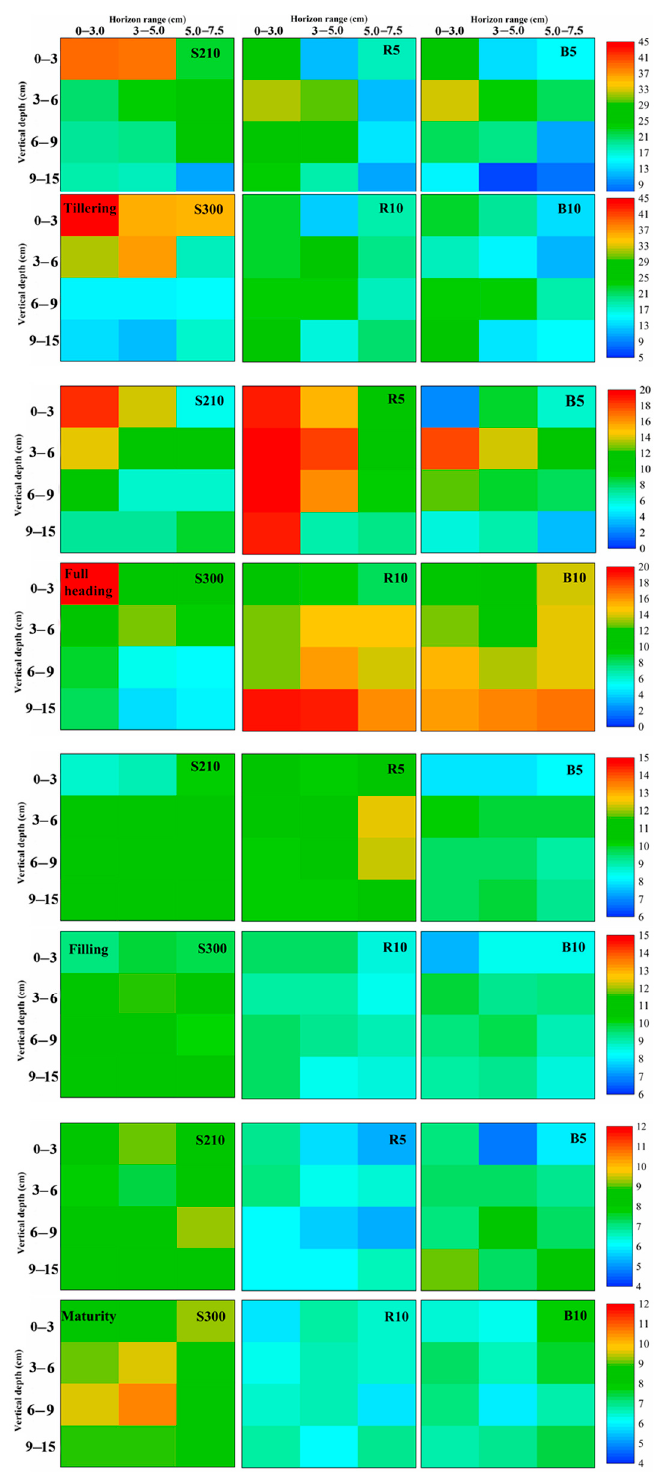
Figure 4. NO 3 − -N content in different soil layers at tillering stage, full heading stage, filling stage and maturity stage and maturity stage (mg/kg).